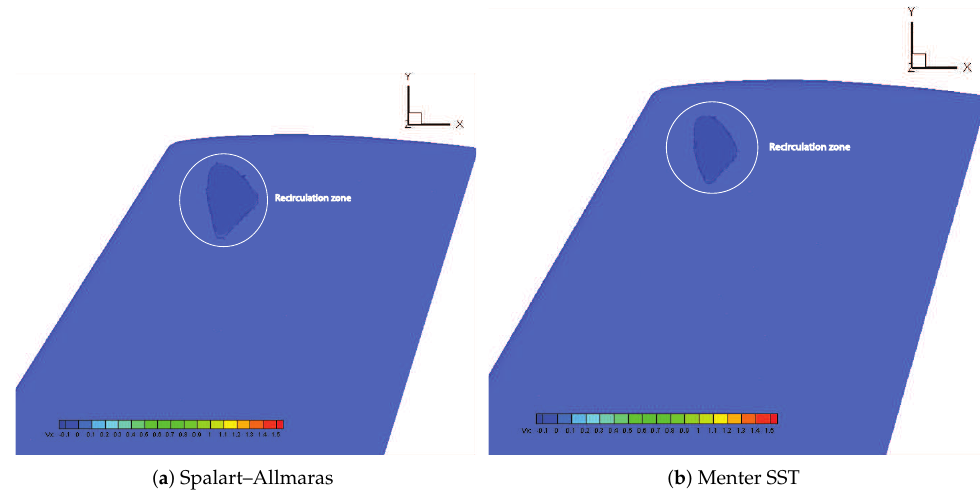
Figure 10. Iso-surfaces of streamwise velocity over the upper surface in the ONERA M6 wing at α = 3.06 ◦ (flow from left to right).